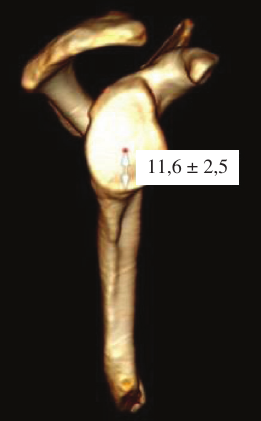
Figure 7. Maximal bone stock.